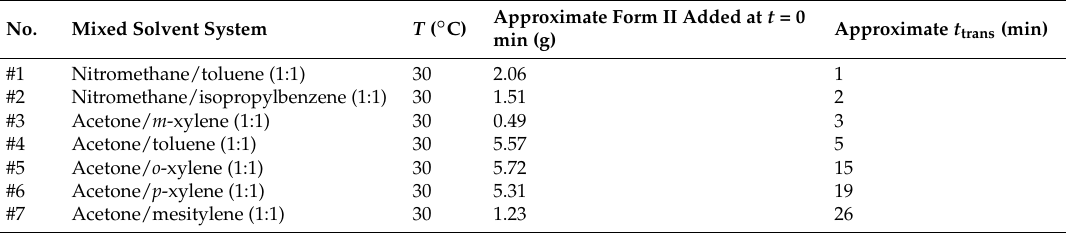
Table 3. Experimental conditions and